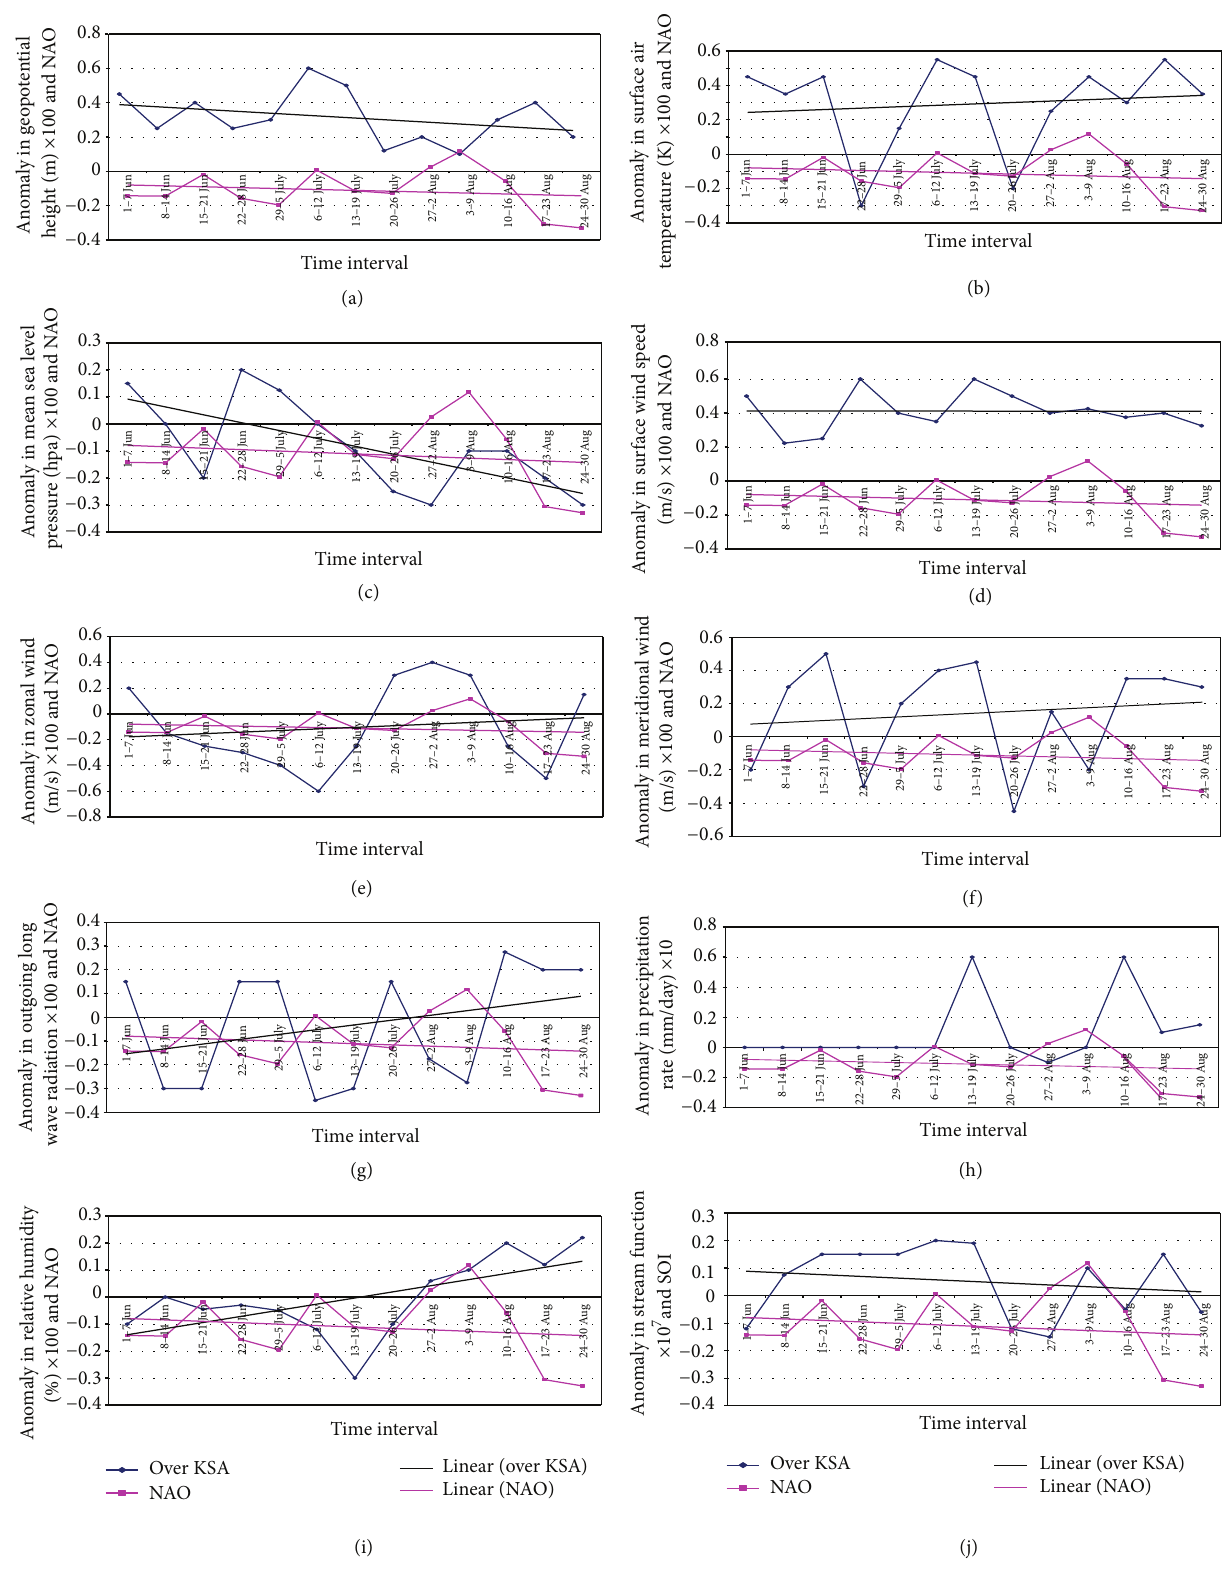
Figure 8: Time series analysis—7 days—of anomaly of NAO and anomaly of weather elements over KSA during the summer season